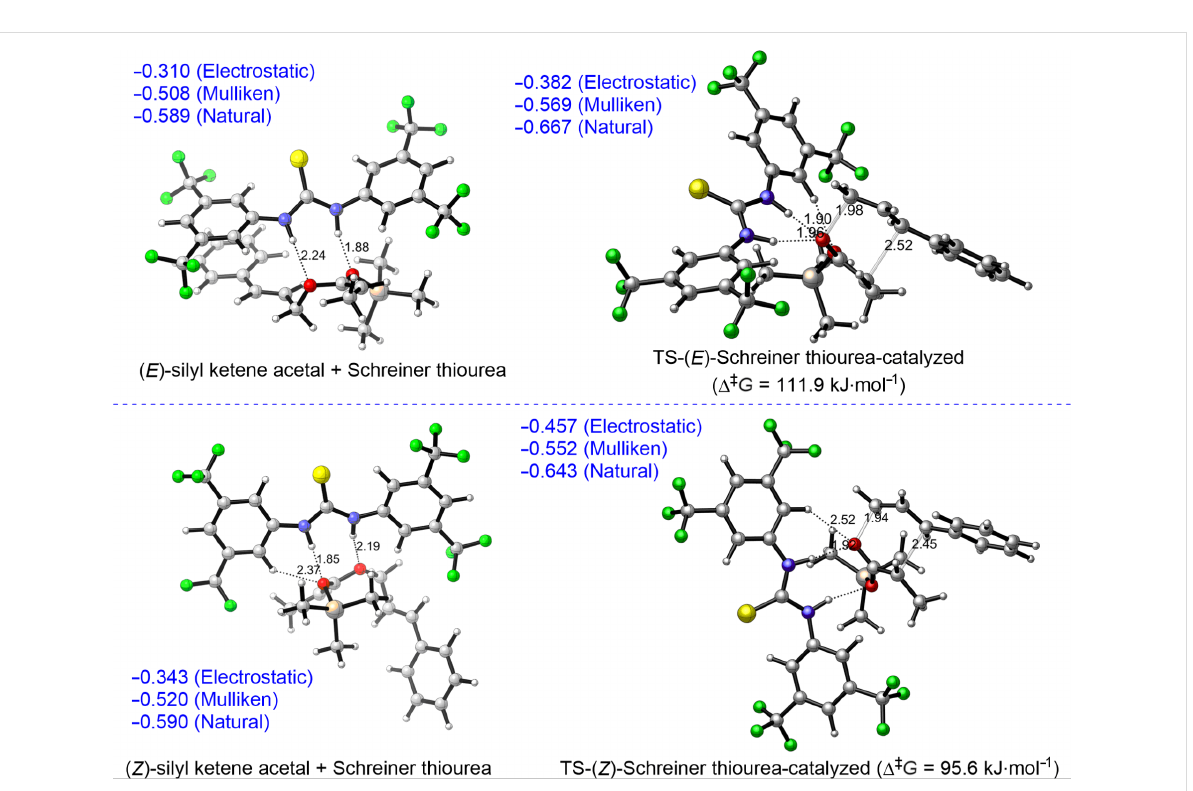
Figure 3: ω B97X-D/6-31G* calculated Schreiner thiourea ( 12 )-catalyzed Ireland–Claisen rearrangement of 1c . Charges on allylic oxygen (blue); C–O bond-breaking and C–C bond-forming distances in TS (black); hydrogen-bond distances